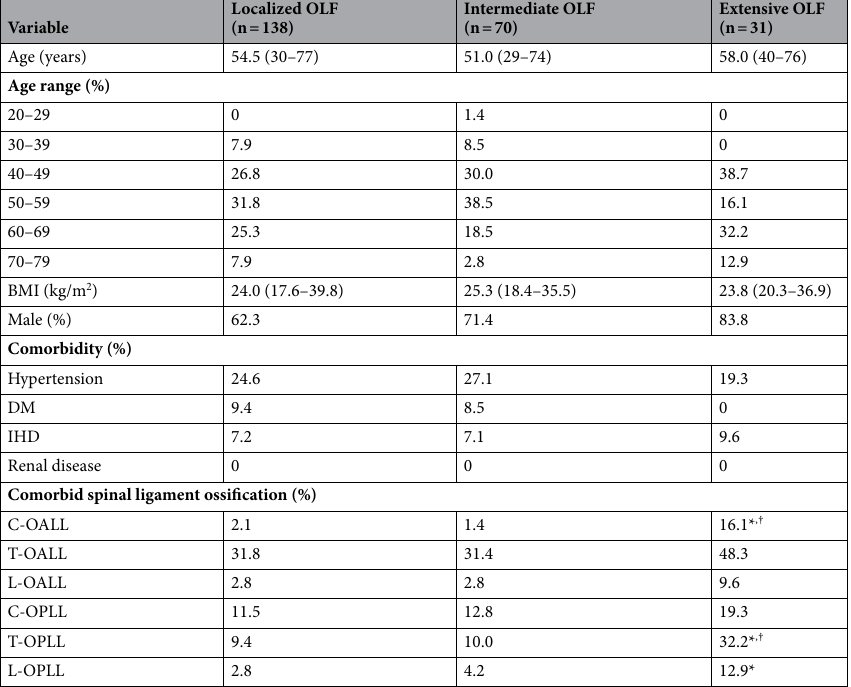
Table 3. Clinical characteristics and rate of comorbid spinal ligament ossification in subjects classified by the severity of OLF. Data are shown as median (minimum–maximum) or as percentage. The three groups are as